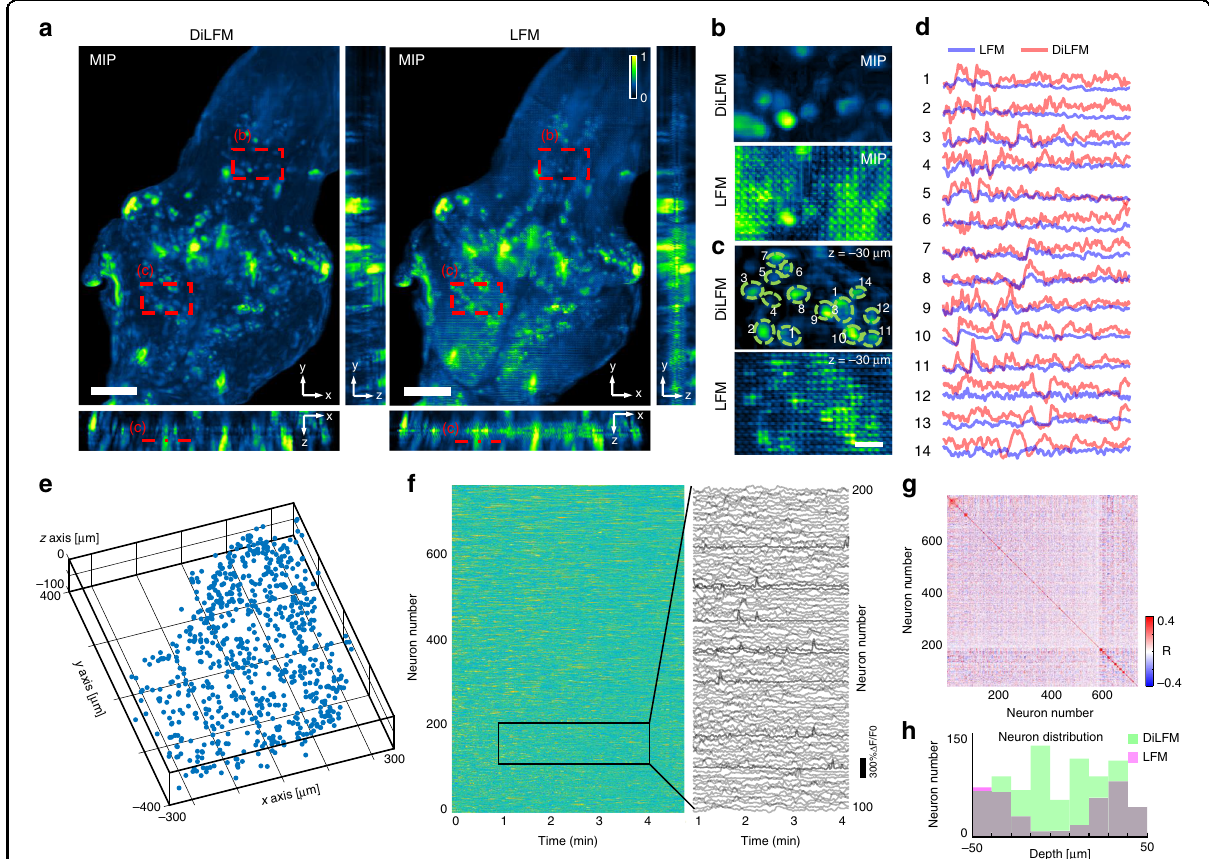
Fig. 5 Zebra fi sh calcium imaging in vivo. a Maximum intensity projection (MIP) along x , y , and z axes of temporal summarized volume (Methods) by DiLFM (left) and traditional LFM (right). The summarized volume is the standard deviation of each reconstructed volume in the time domain. b Zoom-in area marked by red dashed box in ( a ). c Zoom-in area marked by red dashed box in ( a ) with manually labeled neurons shown as green circles. d Inferred neuron activities through CNMF-E of manually labeled neurons in ( c ) by DiLFM (red) and traditional LFM (blue). e 3D distribution of inferred neurons by DiLFM. f Left, neuron activities of 779 DiLFM inferred neurons. Right, zoom-in activities of 100 neurons in a 3 min recording window. g Correlation matrix of DiLFM inferred neurons. h Neuron distributions along the z -axis by DiLFM (green) and traditional LFM (magenta). Scale bars in ( a ) is 100 µm, in ( b ) and ( c ) are 15